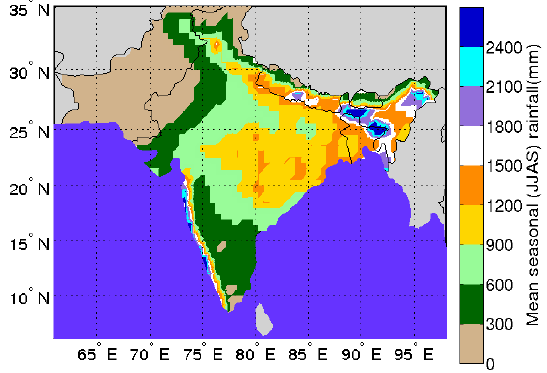
Fig. 1: Topographic map of the region concerned in the data set and the analysis. The colour represents the height above sea level in meters. This map is obtained from ETOPO1, the